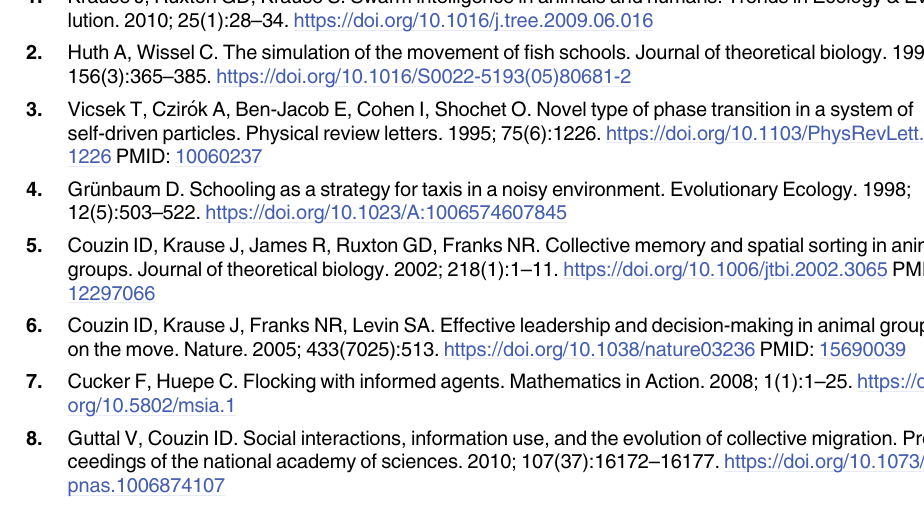
, γ , γ , γ . The non-varied parameters are always set to 0 s l p = 0.5, γ = 1, γ = 1, γ = 0.1. 0 s l p